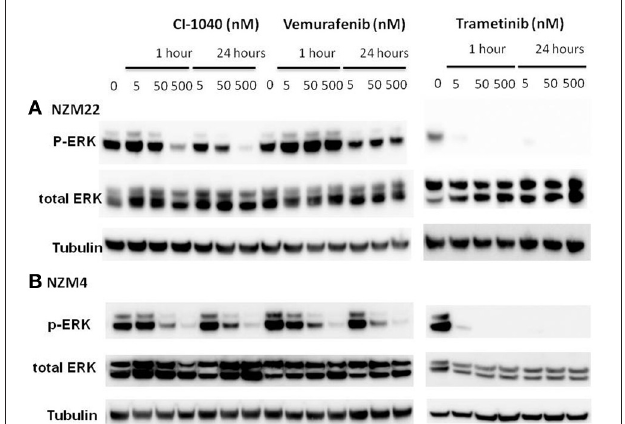
FIGURE 2 | Western blots showing changes in ERK phosphorylation 1 and 24h after addition of different concentrations of the MEK inhibitors CI-1040 and trametinib, and the mutant BRAF inhibitor vemurafenib. (A) NZM22 line (BRAF wild type). (B) NZM4 line (V600E BRAF).